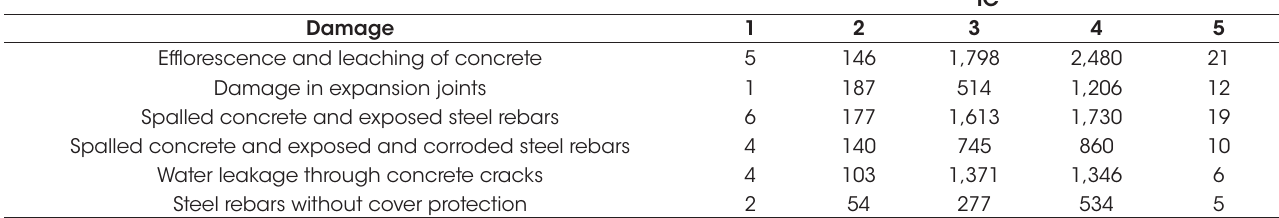
Frequence and IC of major damages registered in DNIT bridges inventory